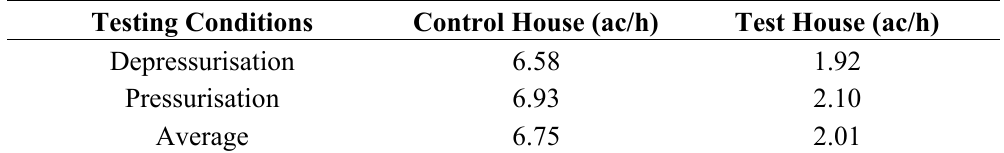
Table 4. Results of airtightness